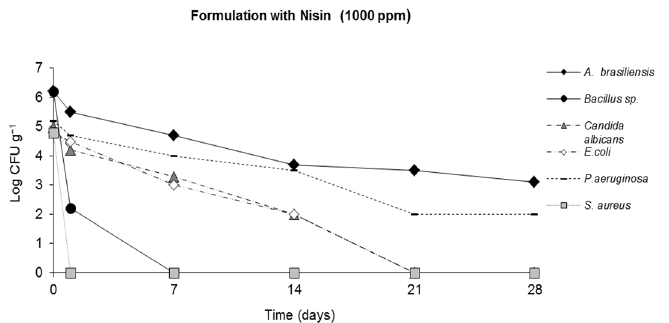
Figure 1. Growth inhibition of different microorganisms in body milk formulation with preservative system nisin 1000 ppm. Cosmetics 2017 , 4 , 41